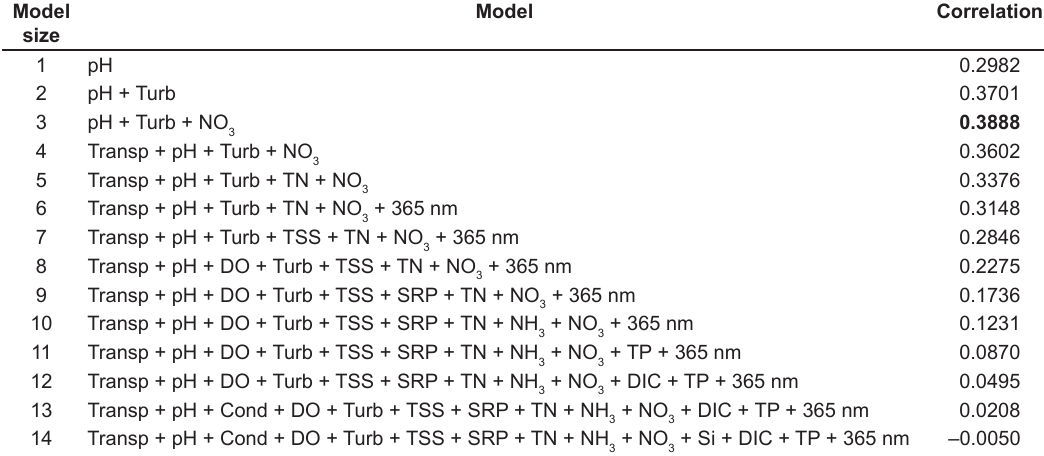
Table 2. Results of the BioEnv analysis for the relationship between the dissimilarity of the phytoplankton community and the dissimilarity of environmental variables in Lake Mangueira, Rio Grande do Sul, Brazil. Spearman correlation for the best model is shown in bold. Cond, electrical conductivity; DIC, dissolved inorganic carbon; DO, dissolved oxygen; NH , ammonium; NO , nitrate; Transp, water transparency; Si, silicon; SRP, soluble reactive phosphorus; 3 3 TN, total nitrogen; TP, total phosphorus; TSS, total suspended solids; Turb,